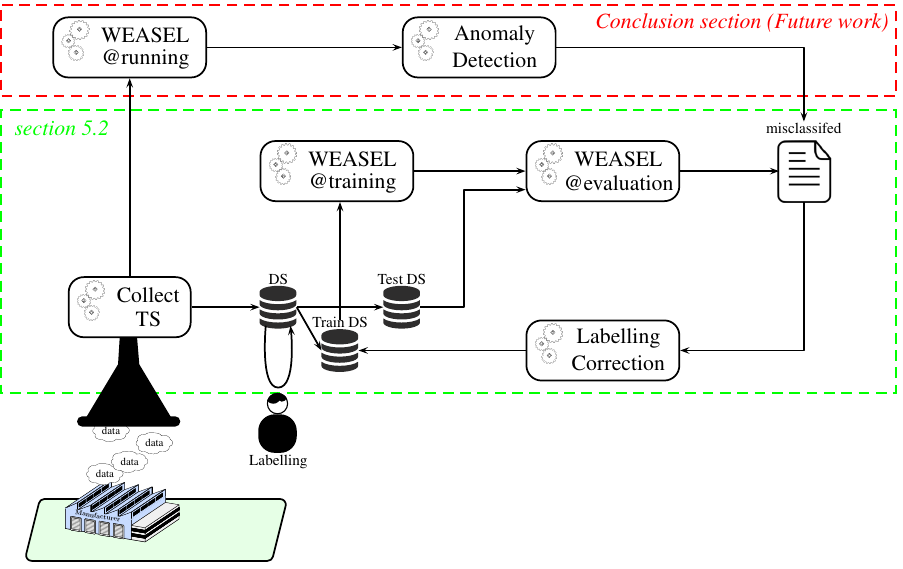
Figure 4. semi-automated (with Machine Learning) integration